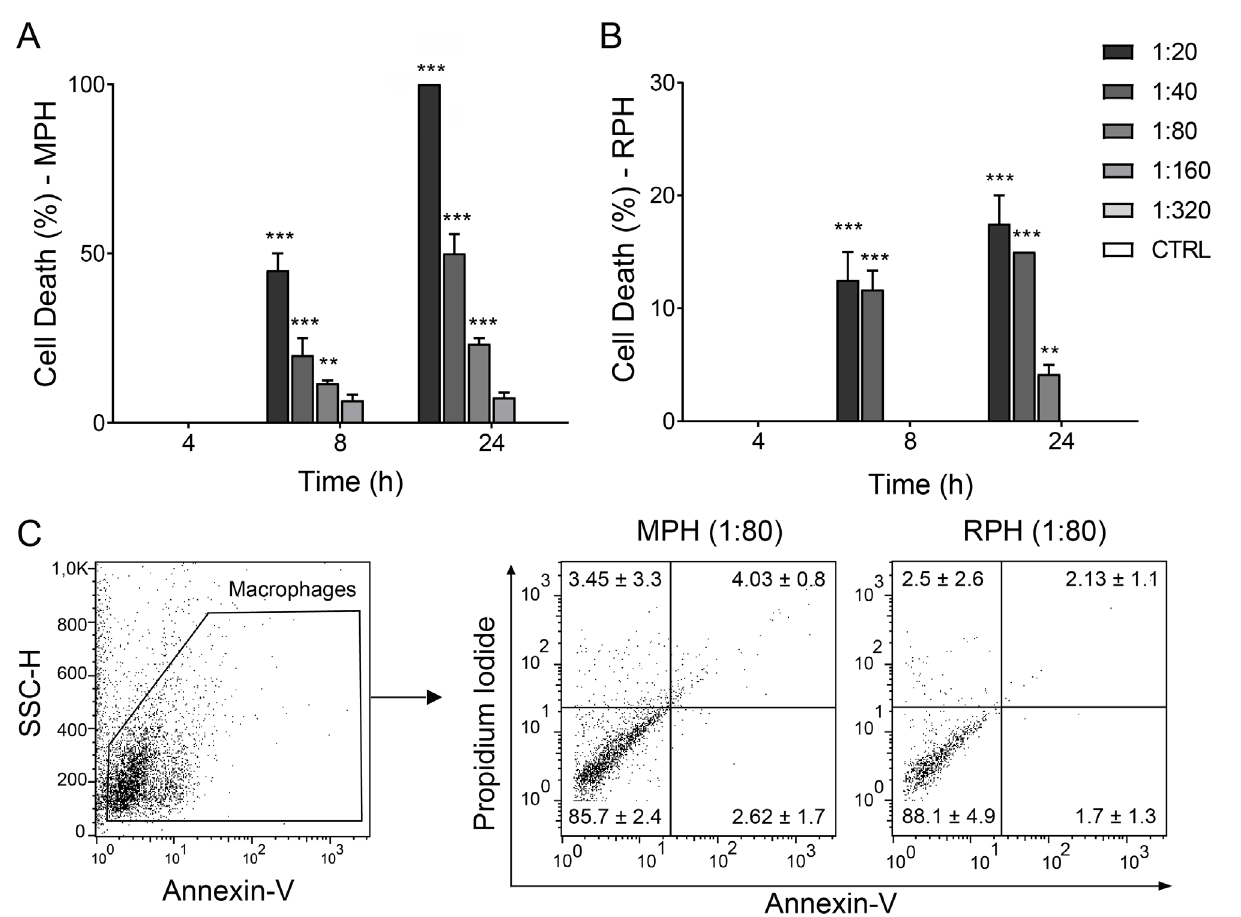
Figure 2. Cytotoxicity test of hemolymph of Meccus pallidipennis and Rhodnius prolixus on RAW264.7 cells. Cell death rate overtime in the presence of (A) M. pallidipennis hemolymph (MPH) or (B) R. prolixus hemolymph (RPH). (C) Annexin-V/Propidium Iodide assay of macrophages incubated with MPH or RPH for 4 hours, in the 1:80 dilution. Data representative of one experiment. The bars represent mean with the standard error of the mean (SEM). The significances are relative to the control group. * p < 0.05; ** p < 0.01; *** p <